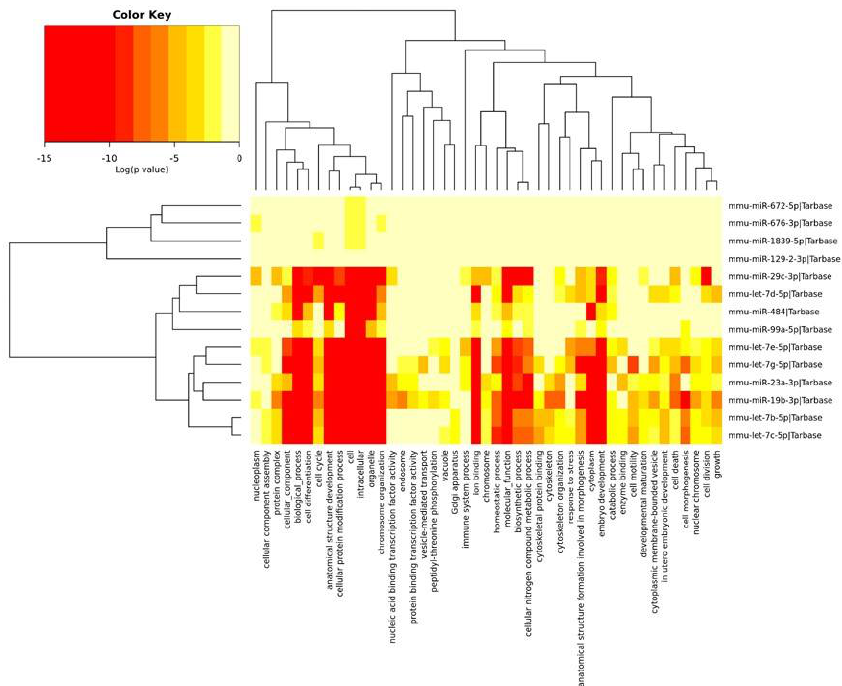
Figure 3. The heatmap indicating the associations of miRNAs with the GO annotations. The miRNAs are on the right-hand side, while the GO annotations are at the bottom of the map. The significances of linking miRNA to GO annotations are color-coded (the scale in the upper-left corner).